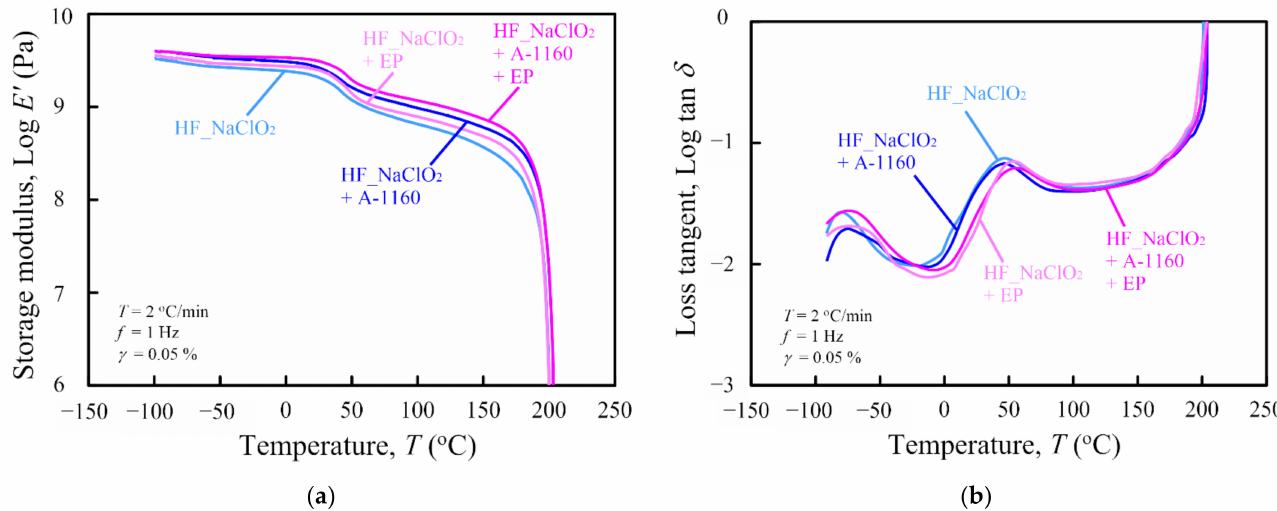
Figure 7. Dynamic mechanical analysis (DMA) curves as a function of temperature for various HF/PA1010 biomass composites: ( a ) storage modulus E’ and ( b ) loss tangent tan δ